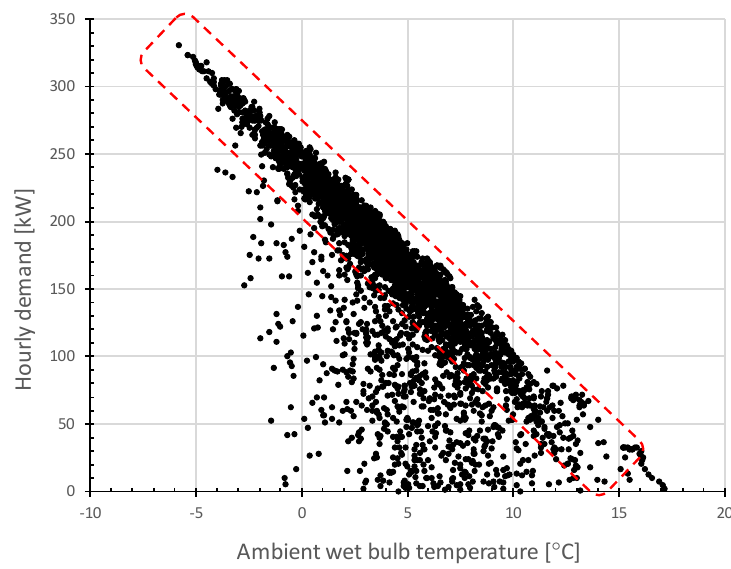
Figure 1. Hourly heating demand profile for each ambient wet bulb temperature for a set of block dwellings in Madrid built between 1981 to 2007 with 6000 m 2 of total heated surface.